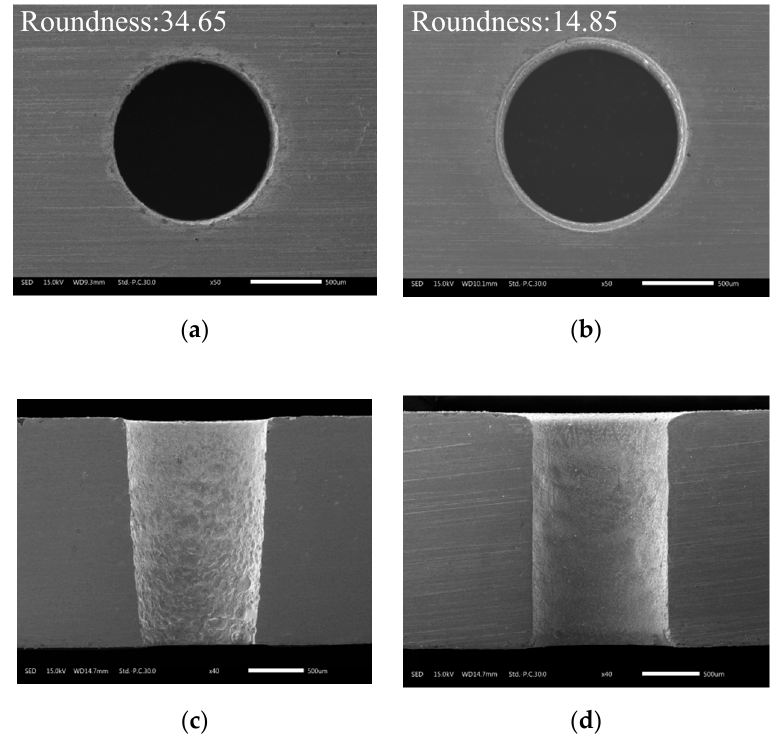
Figure 9. Morphology of ( a , b ) the exit and ( c , d ) the inner wall of holes machined by different methods: ( a ) without ECM; ( b ) after ECM post-processing; ( c ) without ECM; ( d ) after ECM post-processing.